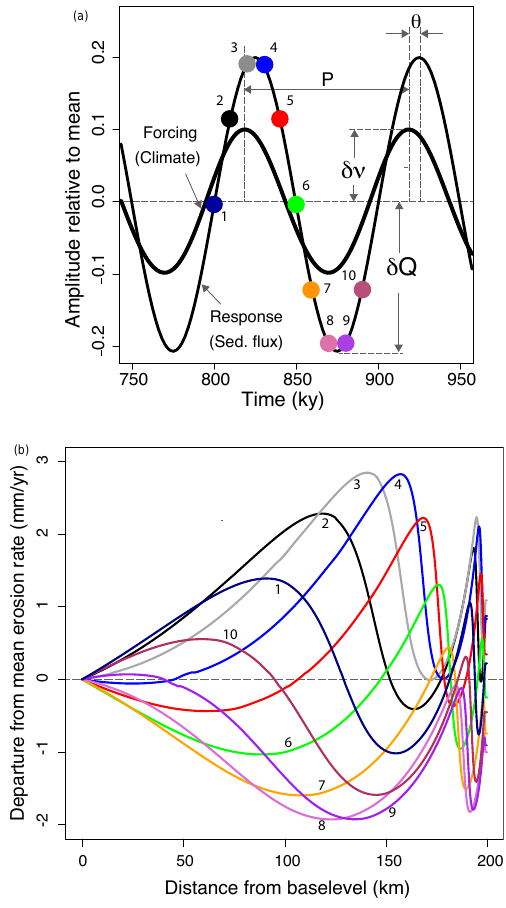
Figure 2. (a) Evolution of precipitation (climate) and the result- ing sedimentary flux through a couple of imposed cycles (here at 100ka) derived from the numerical solution of the stream power law for exponent values of n = 4, m = 2 and p = 2. The phase lag θ and the relation between the variations in precipitation δν and the resulting variations in sedimentary flux ( δQ ), i.e., the gain, are also shown. (b) Erosion rate anomaly along the stream profile at various times during a rainfall cycle; each curve corresponds to a time that is indicated by a circle of the same color in (a) .